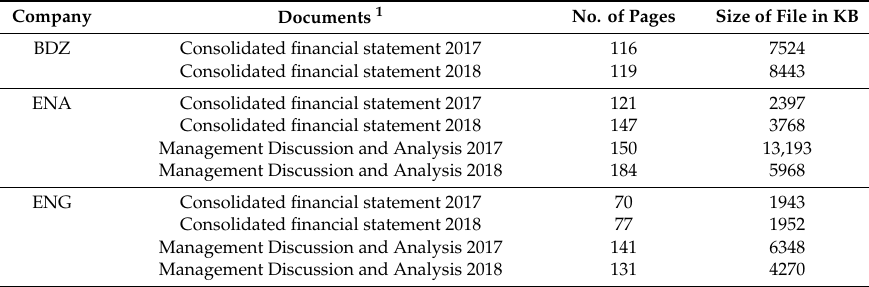
Table A1. Documents subject to textual content analysis (sources of